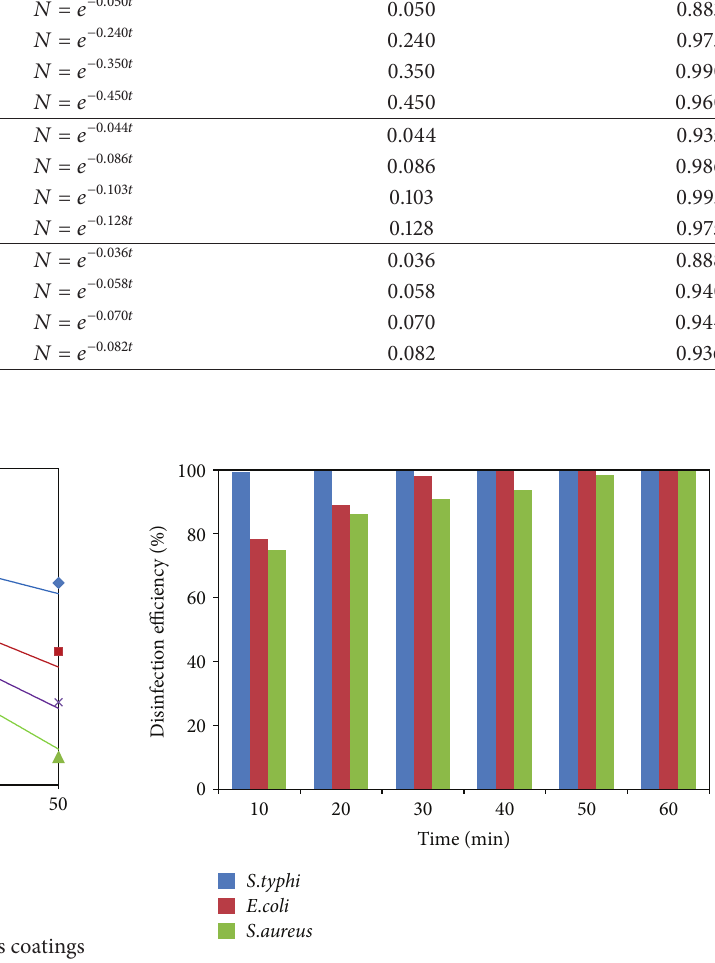
2 /TiO 2 coated glass fibers against S. typhi , E. coli and, S. aureus under UV